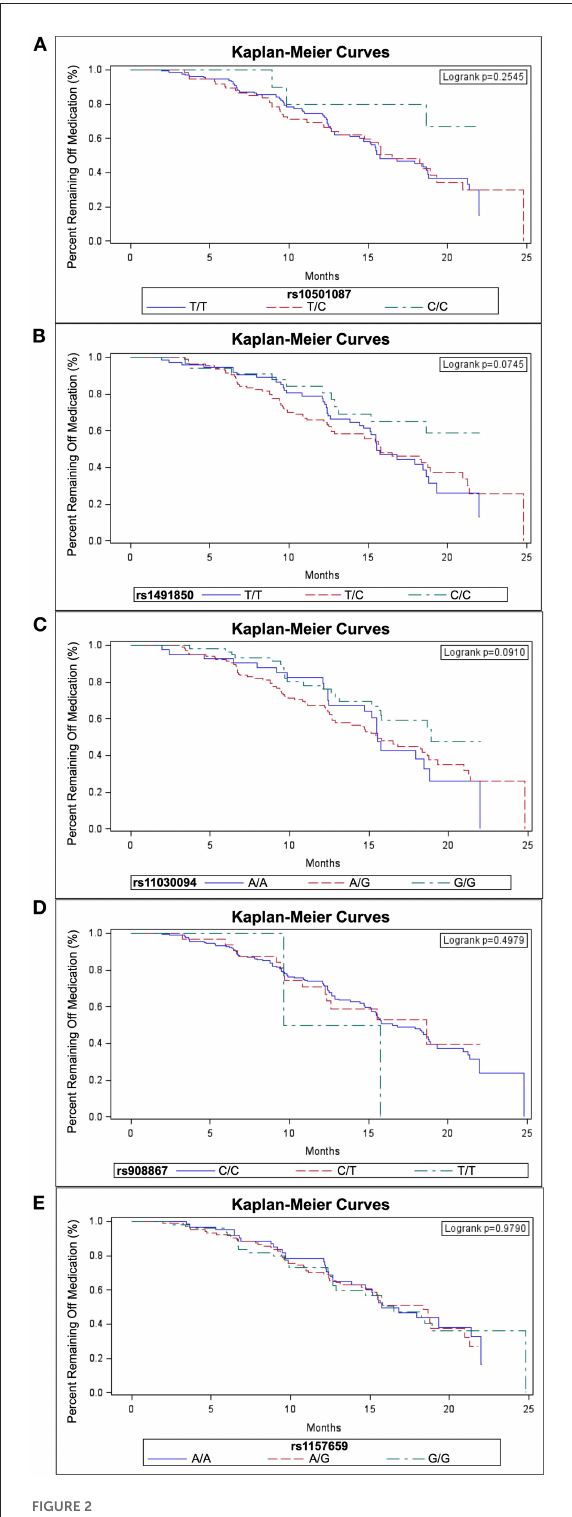
FIGURE2 Survival curves for start of levodopa by BDNF SNP genotypes. Kaplan-Meier survival curves are depicted for the